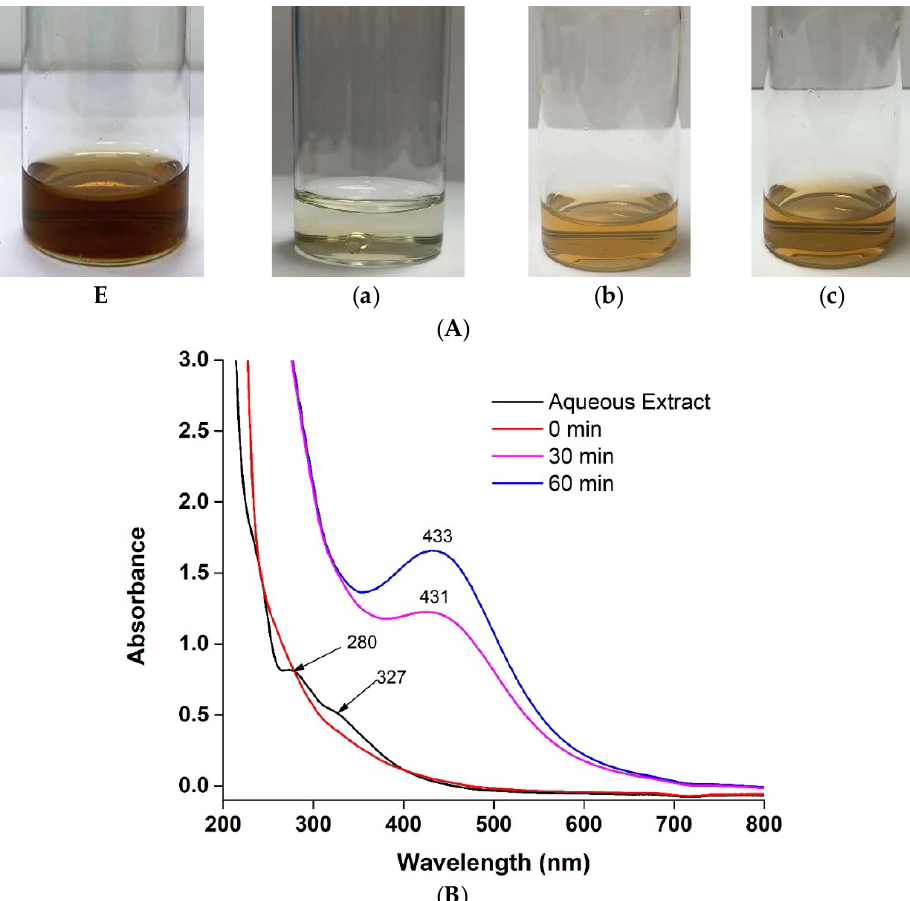
Figure 2. ( A ) Cascabela thevetia aqueous leaf extract color ( E ), and color transformation after mixing with AgNO 3 solution at ( a ) 0 time, ( b ) after 30 min, and ( c ) after 60 min, and ( B ) UV-Vis absorp- tion spectra of Cascabela thevetia aqueous leaf extract alone and with AgNO 3 at 0, 30, and 60 min time